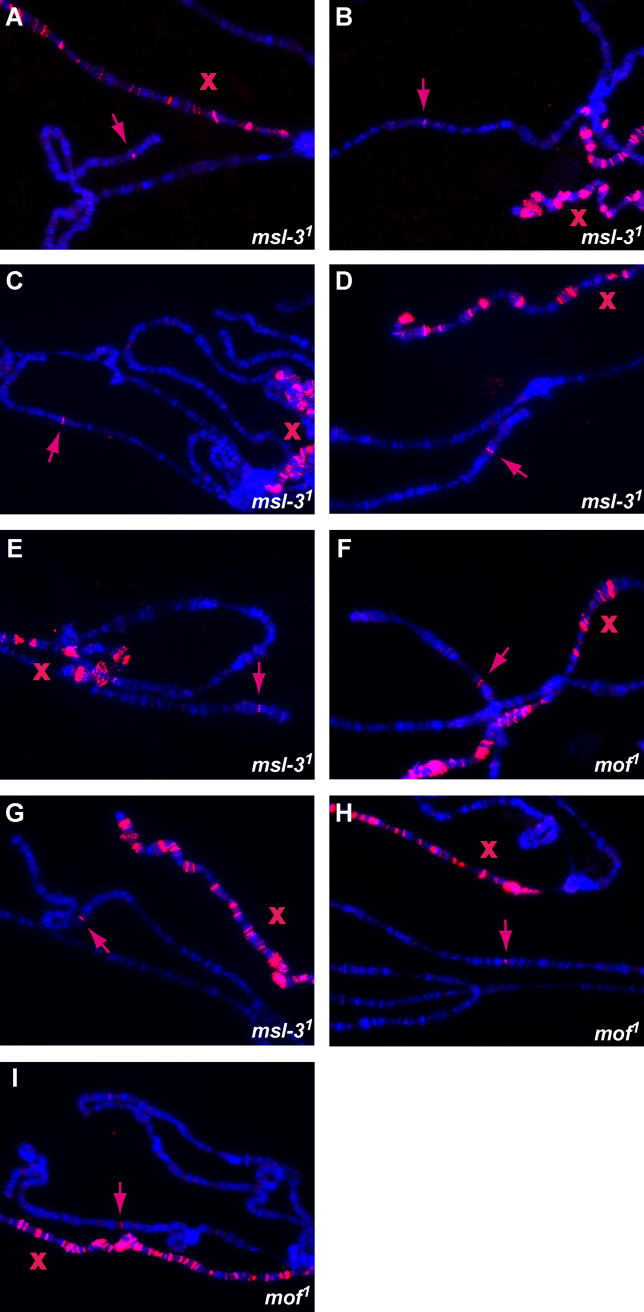
High-Affinity DCC Binding Fragments Recruit Partial and Inactive Complexes in msl-31 and mof1 MutantsExamples of DCC recruitment to DBF inserts in females expressing MSL2 and carrying mutations in msl-31 (w/w; msl-31, [w+ Hsp83 MSL2]/+) or mof1 (mof1/mof1; +; [w+ Hsp83 MSL2]/+). Anti-MSL1 staining is shown in red and DNA staining in blue. Arrows indicate the position of the inserts and X indicates the X chromosome. Inserts DBF12-B-99EF (A), DBF12-B-85A (B), DBF9-B-96C (C), DBF9B-98F (D), DBF6-100A (E), and DBF5-95C (G) recruit partial complexes in the msl-31 mutant. Inserts DBF6-63C (F), DBF5-91F (H), and DBF7-88E (I) recruit inactive complexes in the mof1 mutant background.